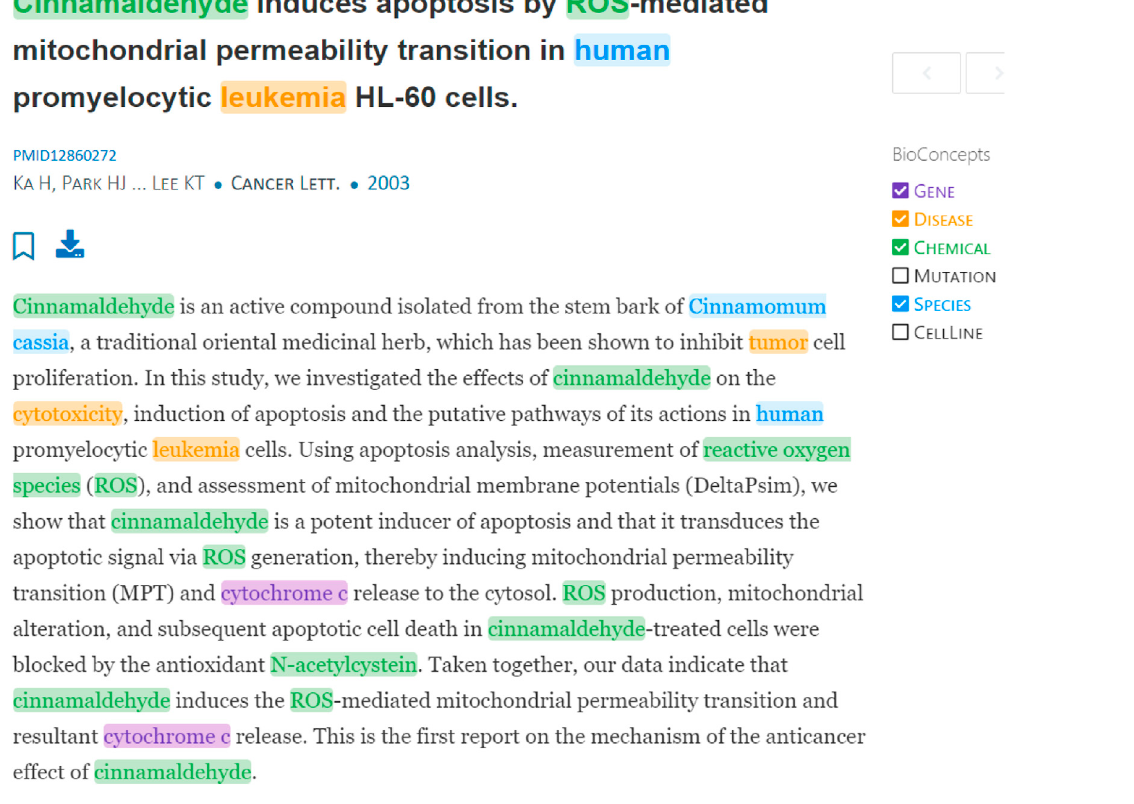
Frontiers in Genetics |